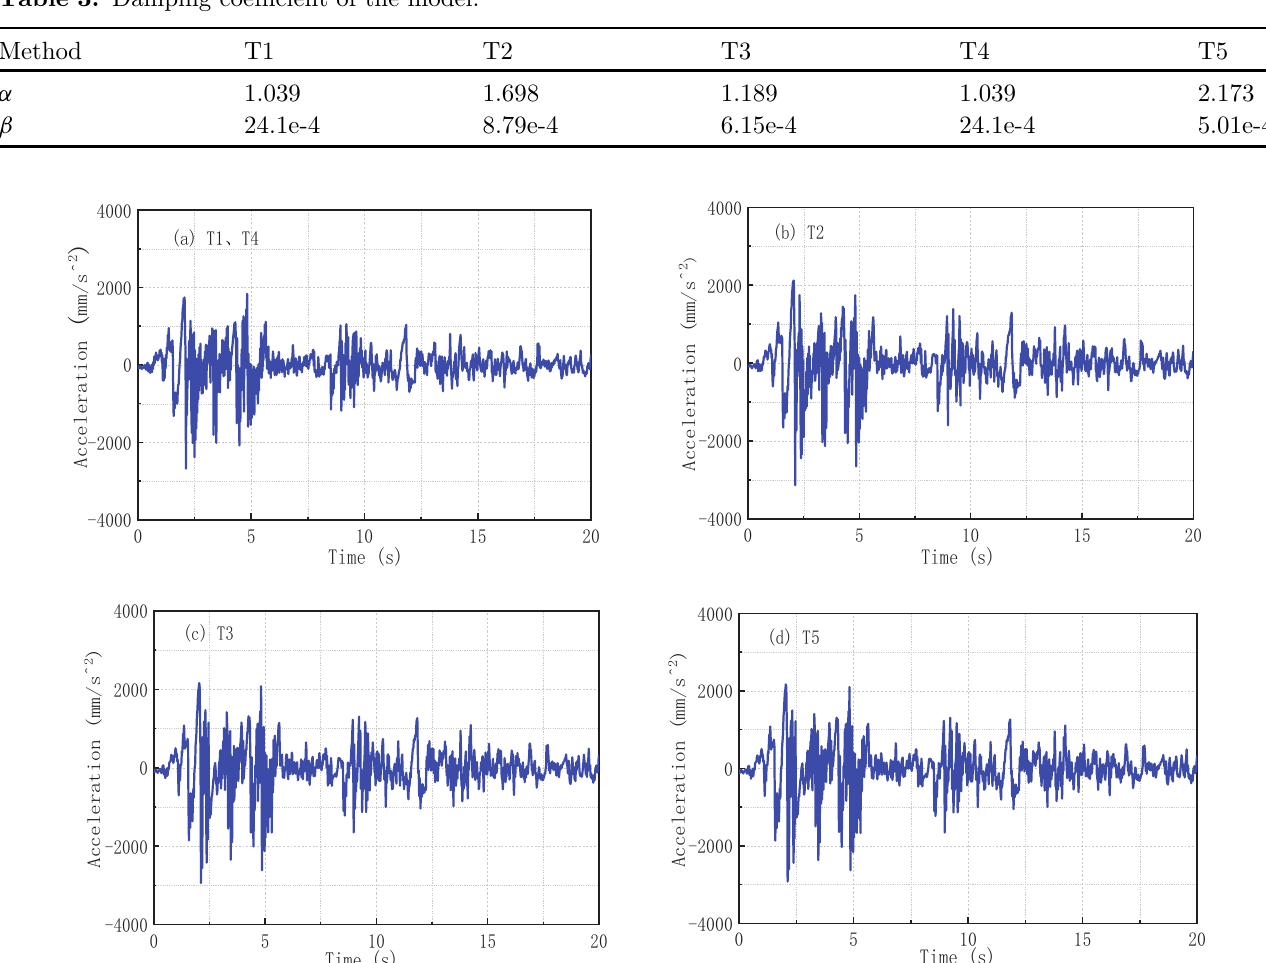
Fig. 3. The time domain characteristic of S3 point under the condition of EL Centro wave 0.22g (a) T1 and T4; (b) T2; (c) T3; (d) From Figure 4, under El-Centro and Taft seismic wave excitation with peak acceleration adjusted to 0.22 g, 0.4 g and 0.62 g, the peak acceleration of measuring points is different under different damping coef fi cient settings (T1-T5), which can be re fl ected in the acceleration ampli fi cation factor. According to the acceleration ampli- fi cation factor at the measurement points, the deviation between the simulation value of different models and the T5 can be calculated. The deviation is more obvious under the action of El-Centro seismic wave with strength of 0.22 g. The deviation between T2 and T5 at measuring point S3 is 7.81%. Under Taft seismic wave, the deviation is smaller, and the maximum value is 2.29% between T1, T4 and T5. It shows that the damping coef fi cient has little effect on the SCC when the peak acceleration is adjusted to